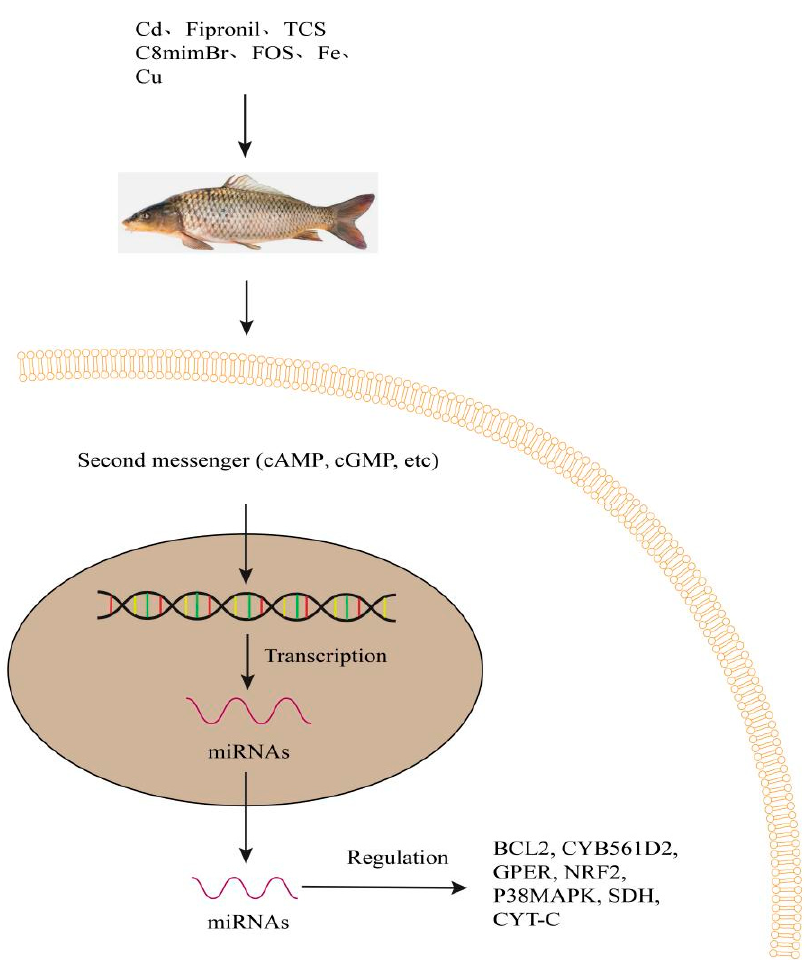
Figure 5. Regulation of BCL2, CYB561D2, GPER, NRF2, P38MAPK, SDH and CYT-C, etc., by miRNAs under environmental chemicals and sea water metal elements in fish. Second messengers induce the transcription of DNA. miRNAs regulate gene expression and function in target genes. They regulate transcription of the target genes and protein synthesis. BCL2, mean B-cell lymphoma 2; CYB561D2, Cytochrome B561 Family Member D2; GPER, mean G protein-coupled estrogen receptor; NRF2, mean nuclear factor erythroid-2-related factor 2; P38MAPK, mean p38 mitogen-activated protein kinases; SDH, mean succinate dehydrogenase; CYT-C, mean cytochrome C; cAMP, cyclic adenosine monophosphate; cGMP, cyclic guanosine monophosphate. The chronic toxicity of 1-methyl-3-octylimidazolium bromide (C8mimBr) was de- termined to further reveal the toxicological mechanisms of ionic liquids in the spleen of miRNA -155 and CYB561D2 were evaluated under stress of fipronil in zebrafish, and silver carp ( Hypophthalmichthys molitrix ). C8mimBr exposure reduced the expression of cytochrome b561 domain-containing protein 2 (CYB561D2) is the major target of miRNA- miRNA-125b and altered the expression of miRNA-143. Upregulation of miRNA-155 and 155. After stimulation of fipronil, the expression of miRNA-155 was downregulated while miRNA-21 levels suggested that these miRNAs may be involved in the C8mimBr-induced mRNA and protein levels of CYB561D2 were upregulated in a dose-dependent manner. inflammatory response. Chronic exposure to ionic liquid C8mimBr indicated that induc- ing inflammation and oxidative stress can be mediated by P38MAPK/NF-KB signaling Dual-luciferase report analysis showed that miRNA-155 interacts with CYB561D2 3’-UTR. pathways (Figure 5)